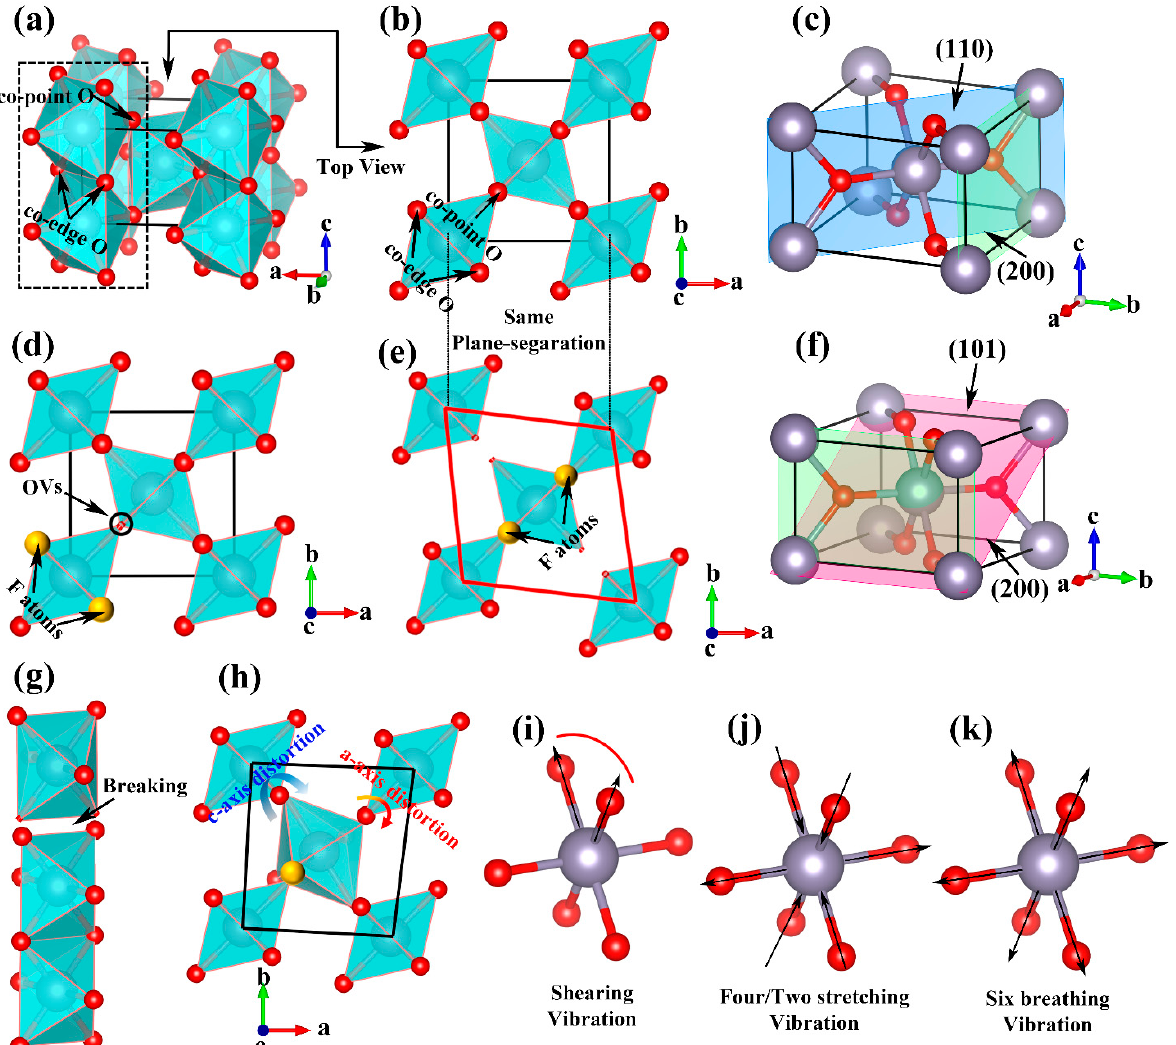
Figure 1. Schematic diagram of SnO 2 structure: three-dimensional octahedral structure ( a ) and its top view ( b ); crystalline cell with (110) and (200) plane ( c ); co-edge O atoms substituted by F atoms in pairs ( d ); distortion of octahedral framework ( e ); crystalline cell with (101) and (200) plane ( f ); the lack of co-edge O atoms in pairs ( g ); co-point O atom substituted by F atom ( h ); schematic diagram of atom vibration in SnO 2 structure, including the shearing vibration ( i ), the stretching vibration ( j ) and the breathing vibration ( k ).